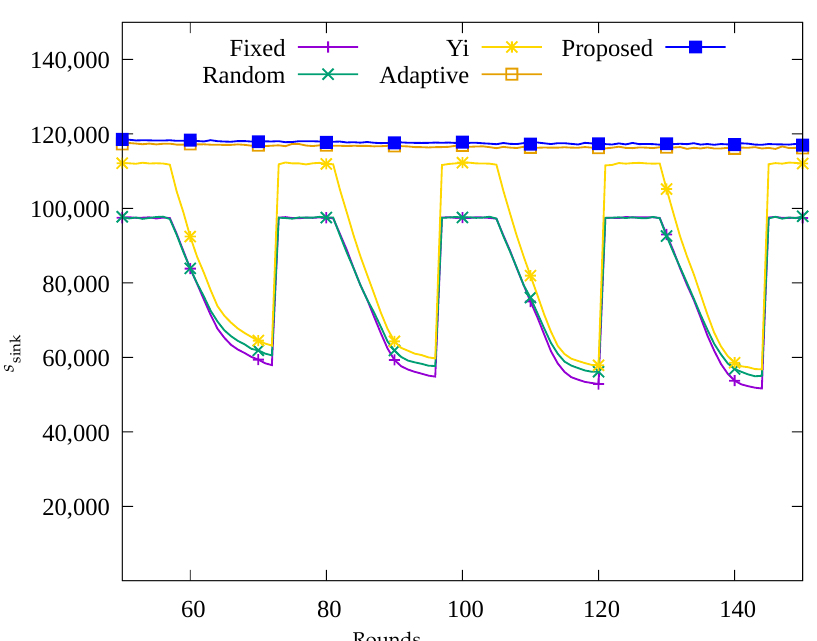
Figure 7. Comparison of the amount of data gathered at the sink node over time.